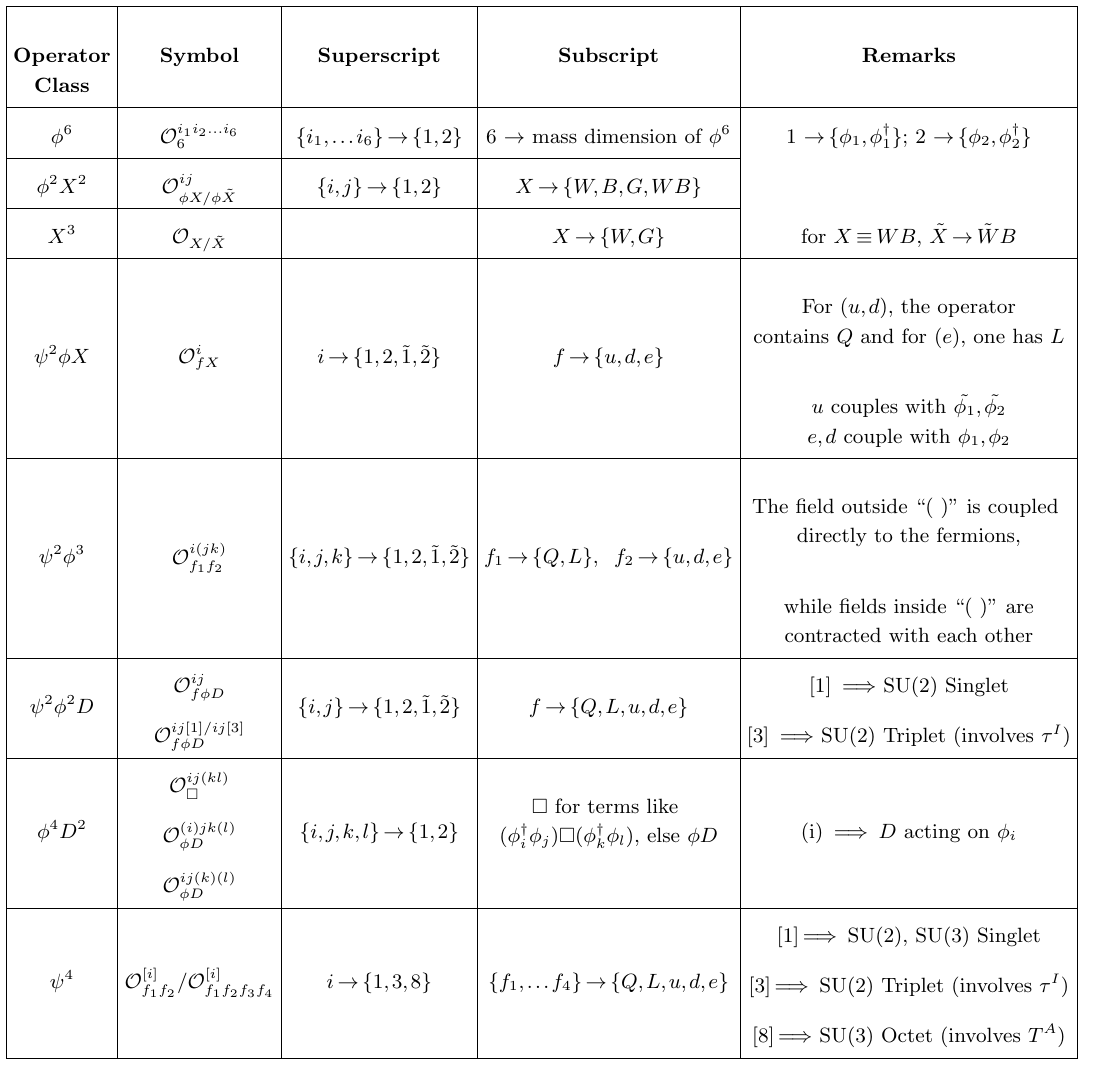
Table 2. 2HDM: summary of the nomenclature of operators.